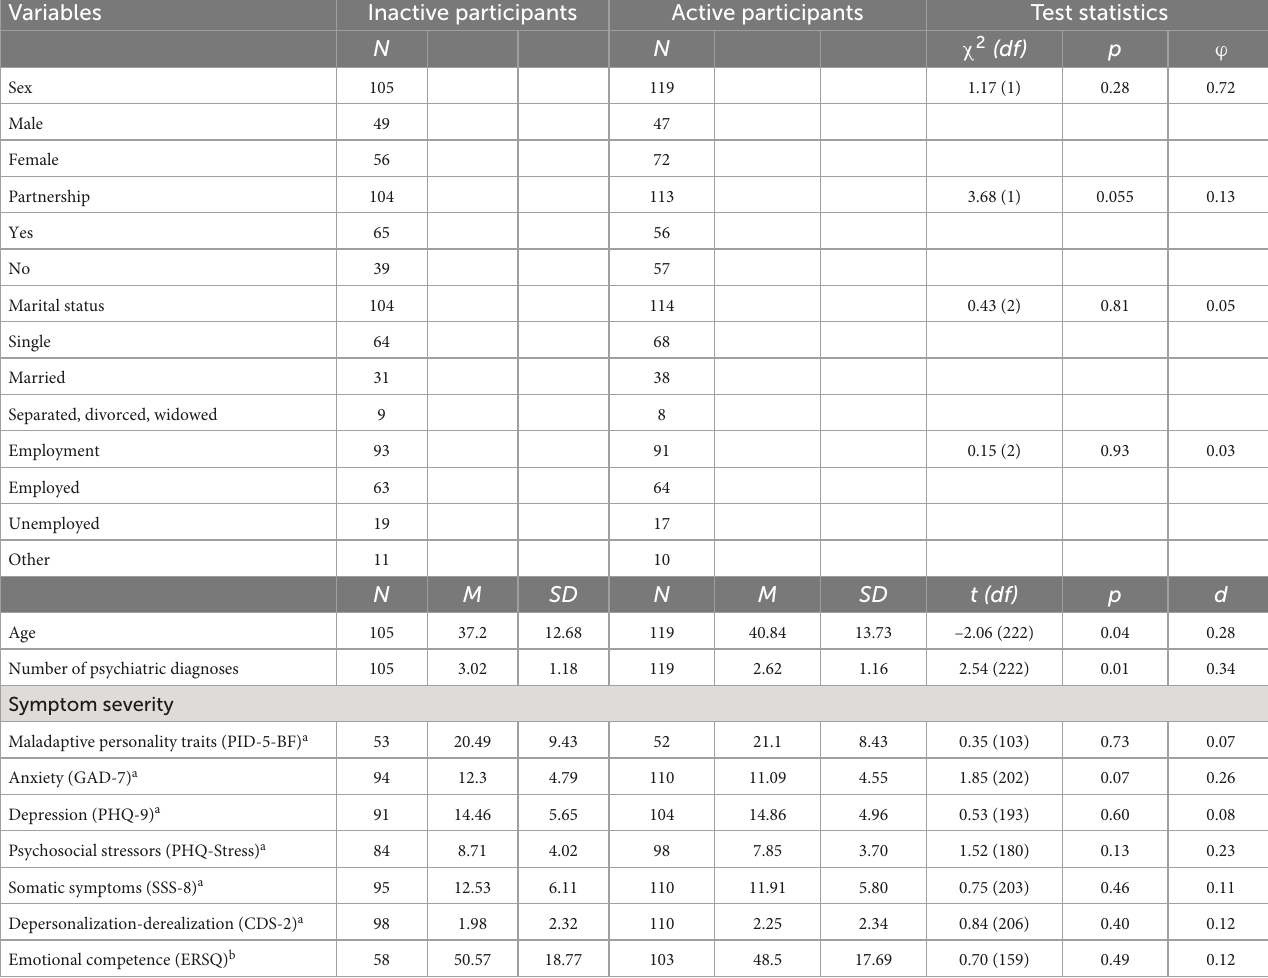
TABLE 2 Descriptive and test-statistics of the comparison between inactive and active participants.